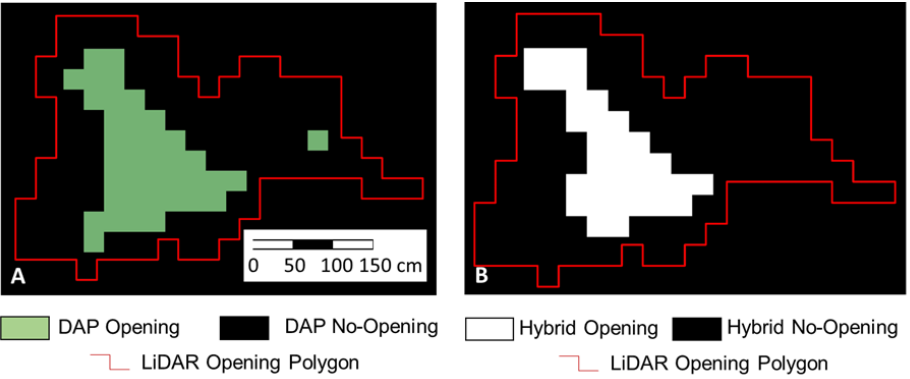
Figure 4. An example of determining the percent area of a LiDAR polygon identified by DAP (green) and hybrid (white) data. Panel A represents LiDAR polygon over DAP opening map. Panel B represents LiDAR polygon over hybrid opening map. The area of the opening pixels was compared to the area identified as openings by the LiDAR polygons.